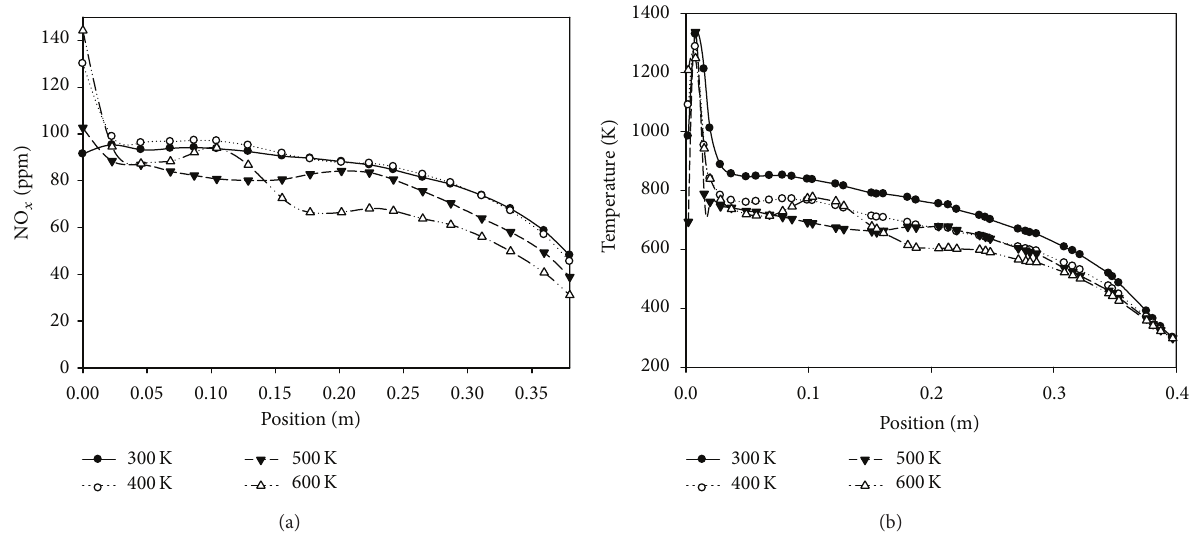
Figure 10: Effect of preheating air on the central (a) NO 𝑥 profile and (b) temperature profile.